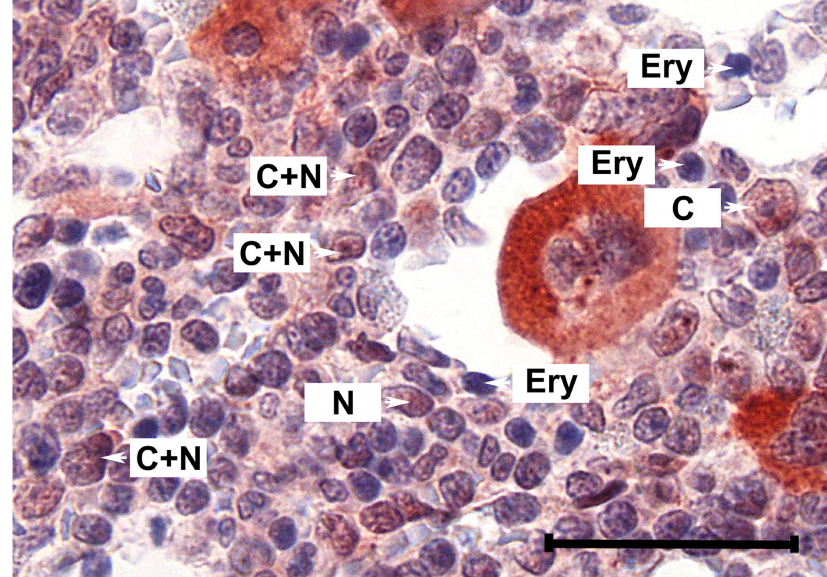
Figure A1. The picture shows an enlarged part of the picture of patient #06 (PV) from Figure 1A. The arrows point at examples of cytoplasmic ‘C’, nuclear ‘N’ and cytoplasmic / nuclear ‘C + N’ staining. ‘Ery’ marks examples of erythroid cells that were used as internal negative controls. Scale bar: 30 µ